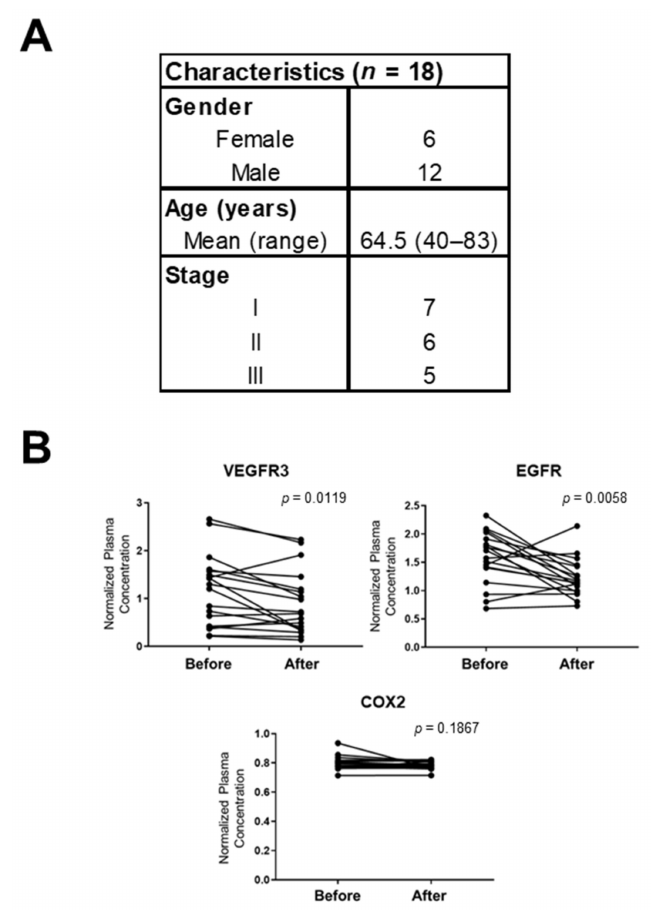
Figure 4. Correlation of plasma VEGFR3, EGFR, and COX2 with surgical resection in patients with rectal cancer. ( A ). Subject characteristics in the pre-and post-surgery RC set. ( B ). Levels of VEGFR3, EGFR, and COX2 in plasmas collected at the time of diagnosis (Before) and 5 to 7 months after surgery (After) from 18 rectal cancer patients. p values were calculated by paired t